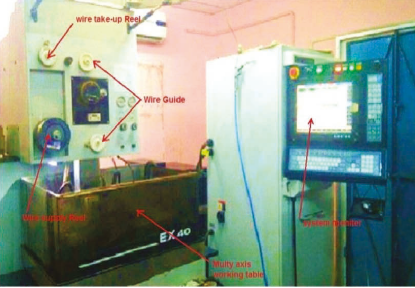
Figure 4: Wire cut EDM machine setup.